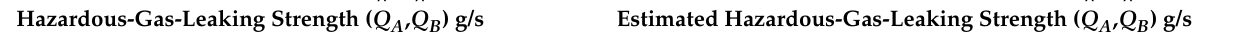
Table 6. Online STE results in the noise-free case.